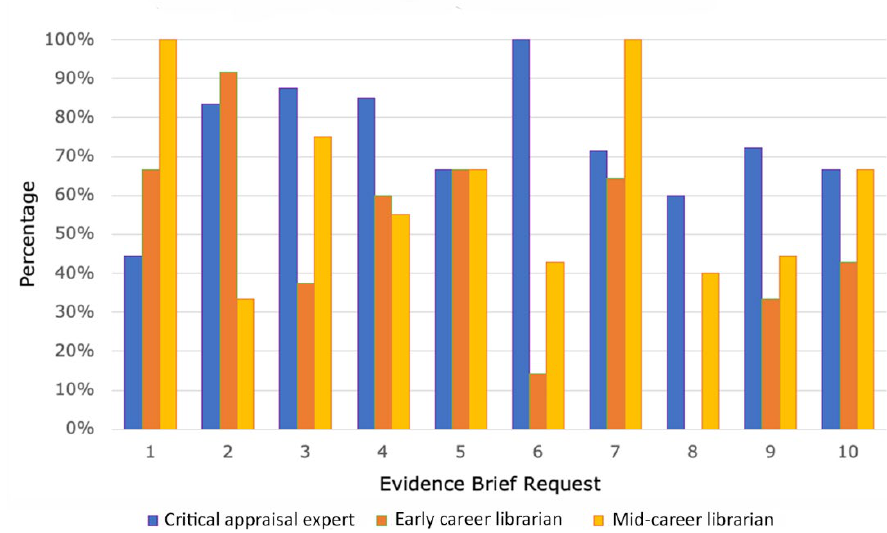
Figure 3 Percentage of references included in Evidence